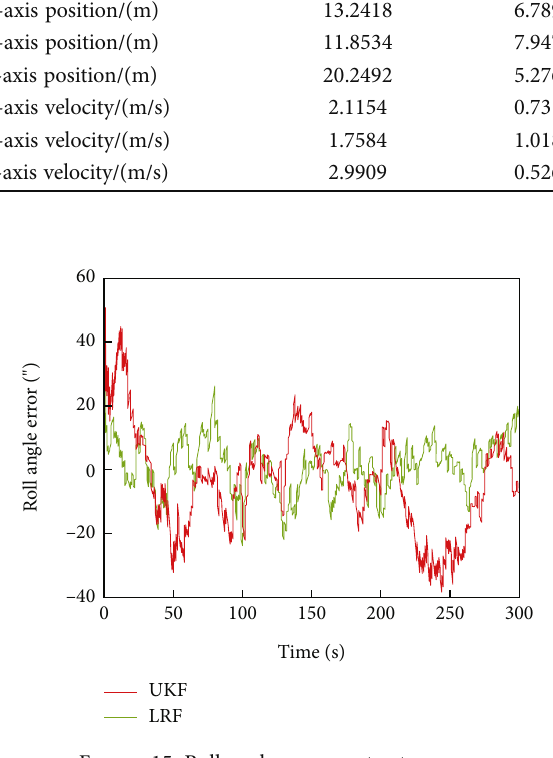
Figure 15: Roll angle error contrast curves.